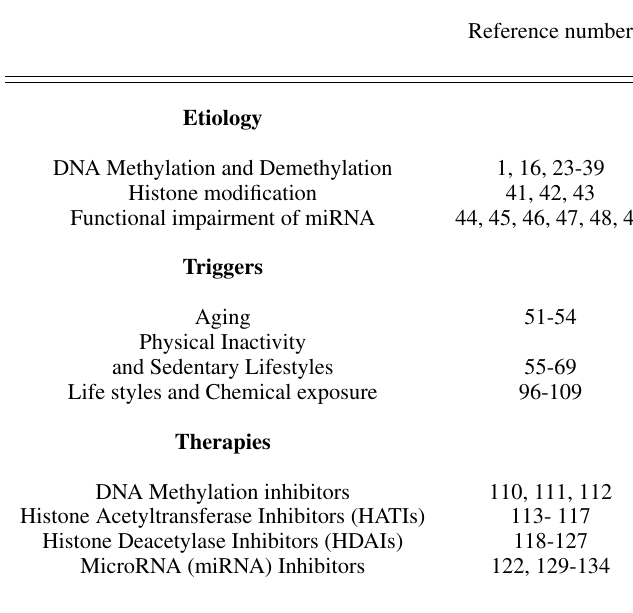
Table 1. Reference numbers by